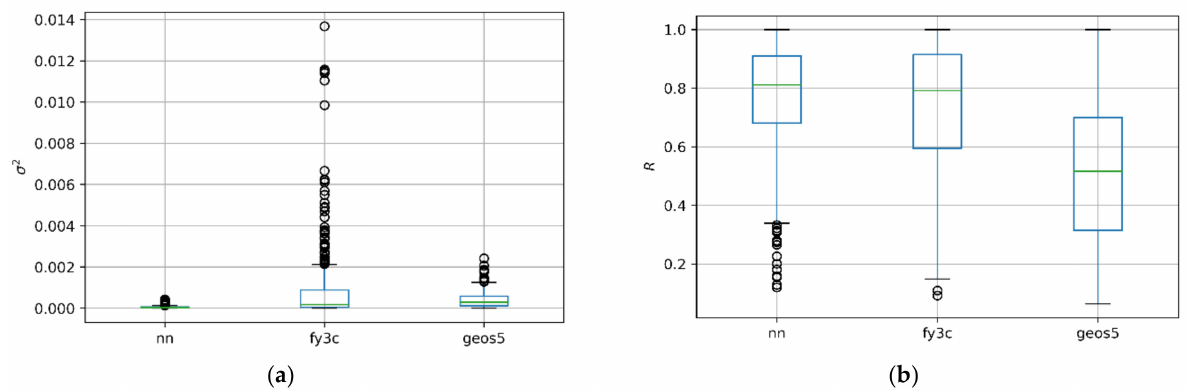
Figure 8. ( a ) Box-whisker plots of error variance for NN SM, FY3C SM, and GEOS-5 SM compared with actual SM data. ( b ) Box-whisker plots of correlation coefficients for NN SM, FY3C SM, and GEOS-5 SM compared with actual SM